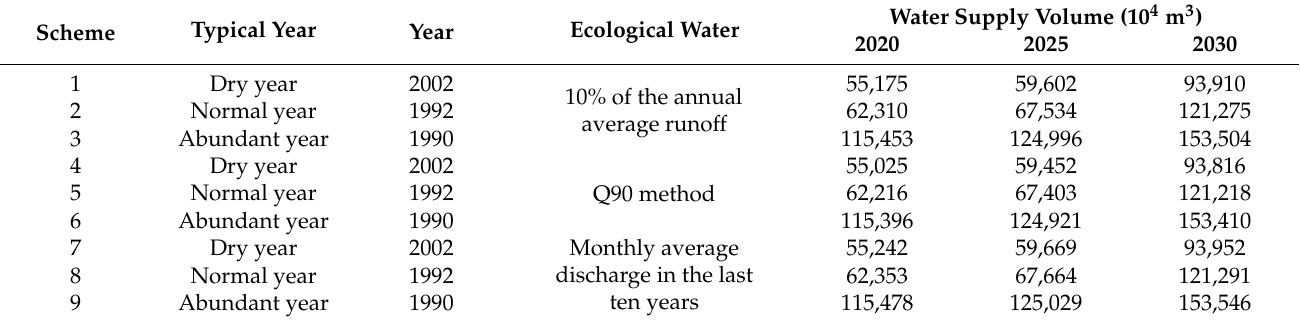
Table 3. Simulation-calculation results of water-supply